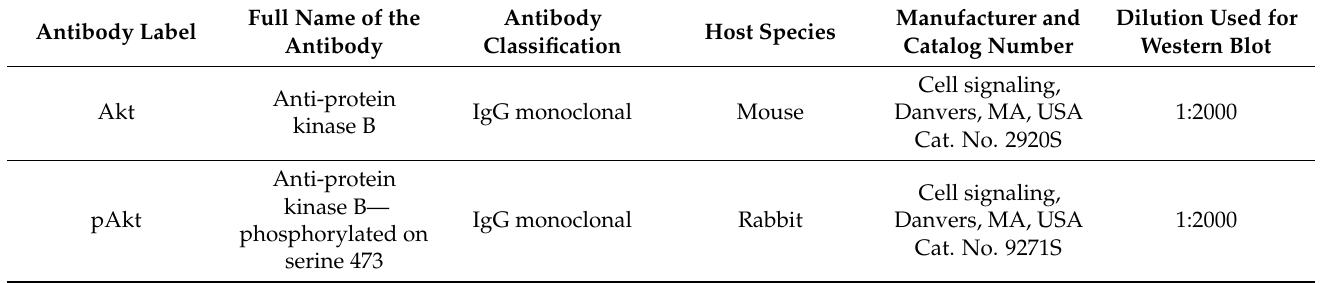
Table 1. List of primary antibodies, secondary antibodies and tertiary complex used for the Western blot